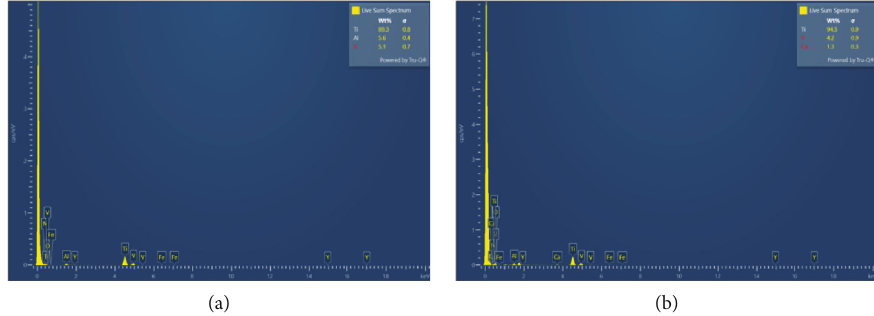
Figure 8: EDS mapping elements before corrosion (a) and after corrosion